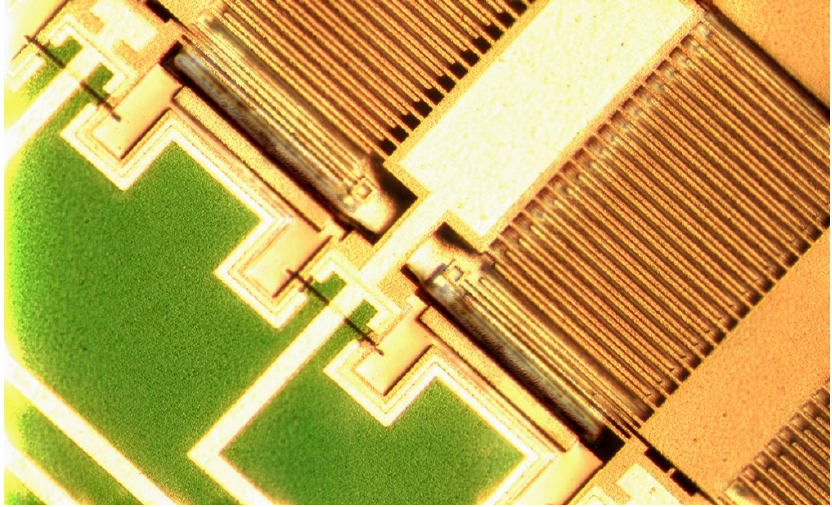
Figure 6. X-axis accelerometer photography.